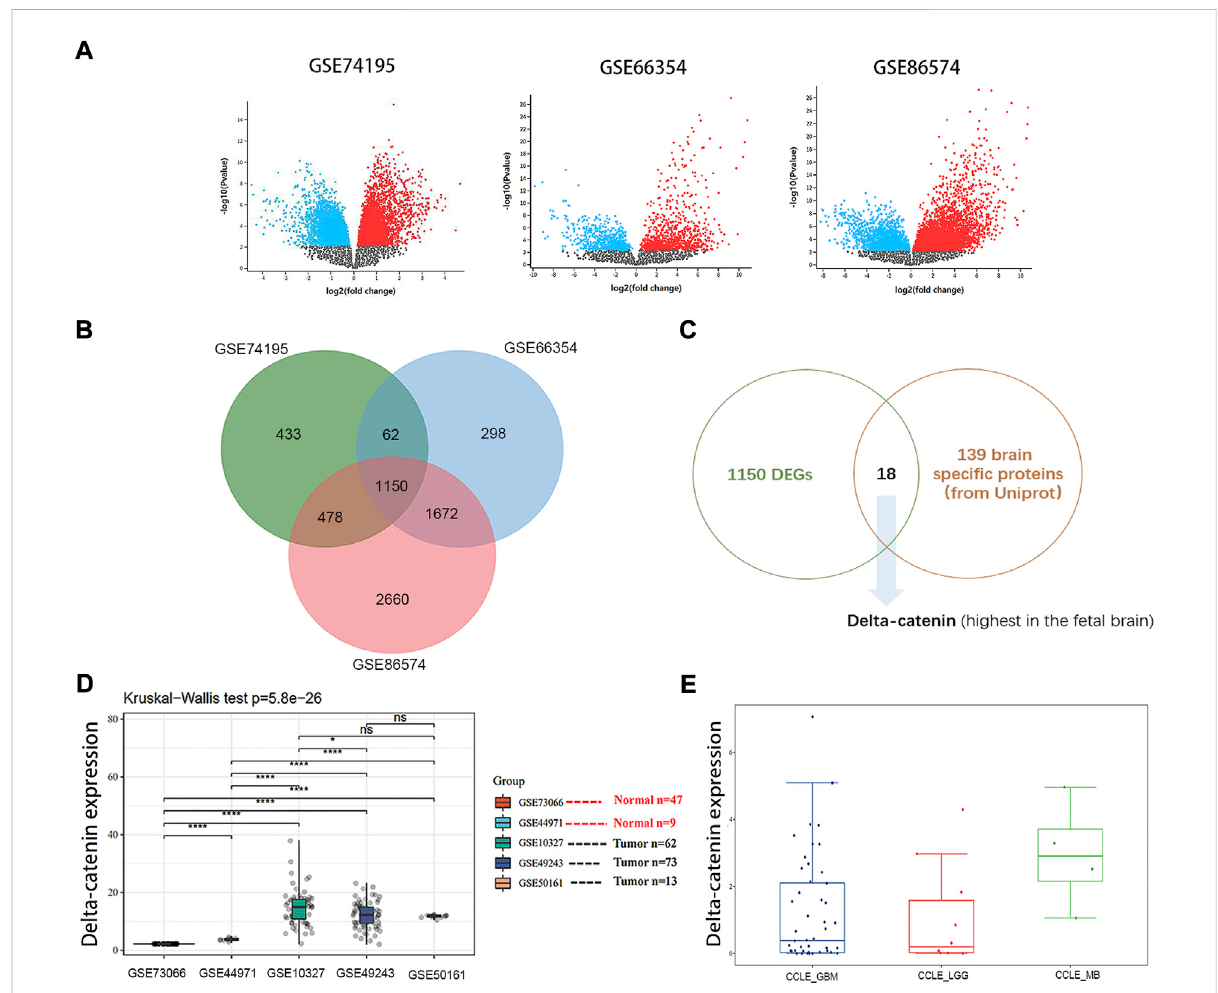
FIGURE 1 Delta-catenin is identi fi ed by a fi ltering strategy. (A) DEGs for medulloblastoma in three independent, nonoverlapping datasets were identi fi ed. (B) The overlap of the three datasets contains 1150 DEGs. (C) Flow diagram for screening out delta-catenin. (D) Delta-catenin expression is particularly high in medulloblastoma tissue compared to normal tissue controls ( p < 0.0001) in fi ve independent nonoverlapping cohorts. (E) Delta- catenin expression in various brain tumor cell lines (e.g., U87 and U251 for GBM, SF767 and SW1088 for LGG, Daoy and D283 for